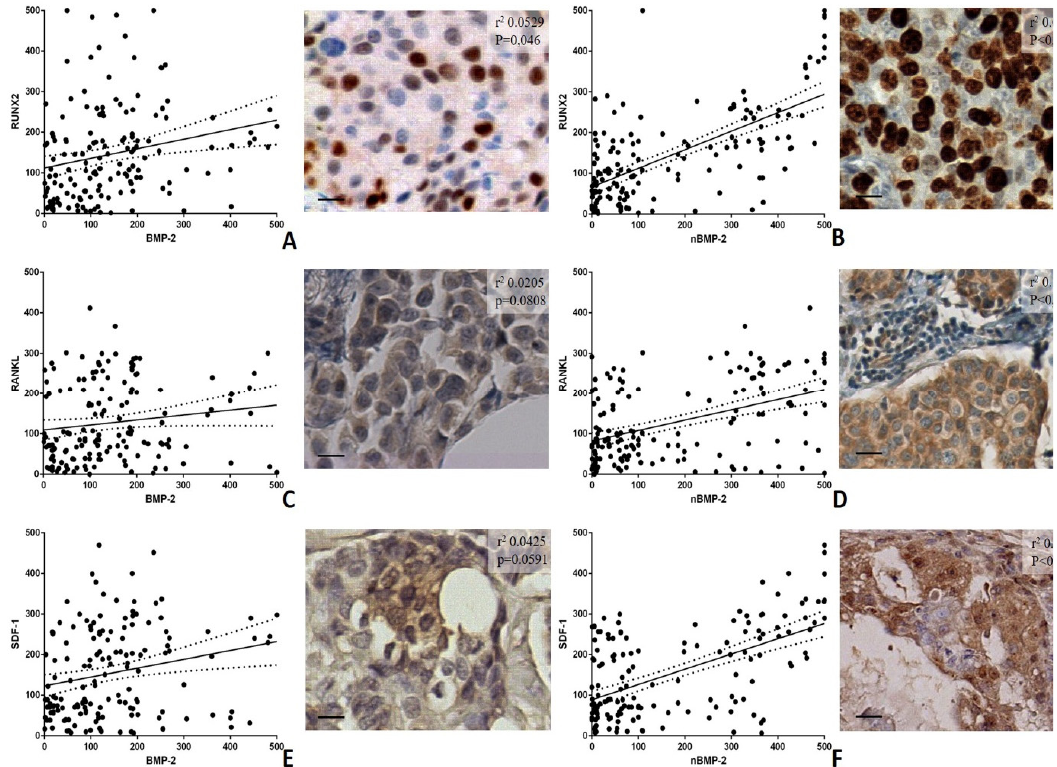
Figure 4. Linear regression analysis of the association among cytoplasmic BMP-2, nBMP-2, and bone biomarkers RUNX2, RANKL and SDF-1. ( A ) The graph displays significant association between the number of BMP-2-positive cells and RUNX2. The image shows some RUNX2-positive breast cancer cells in an infiltrating breast carcinoma. ( B ) The graph shows a significant association between the number of nBMP-2-positive cells and RUNX2. The image displays numerous RUNX2-positive breast cancer cells in an infiltrating breast carcinoma. ( C ) The graph displays no association between the number of BMP-2-positive cells and RANKL. The image shows some RANKL-positive breast cancer cells in an infiltrating breast carcinoma. ( D ) The graph displays significant association between the number of nBMP-2-positive cells and RANKL. The image displays several RANKL-positive breast cancer cells in an infiltrating breast carcinoma. ( E ) The graph displays no association between the number of BMP-2-positive cells and SDF-1. The image shows rare SDF-1-positive breast cancer cells in an infiltrating breast carcinoma. ( F ) The graph shows significant association between the number of nBMP-2-positive cells and SDF-1. The image shows some SDF-1-positive breast cancer cells in an infiltrating breast carcinoma. The scale bar represents 200 μ m for each image.